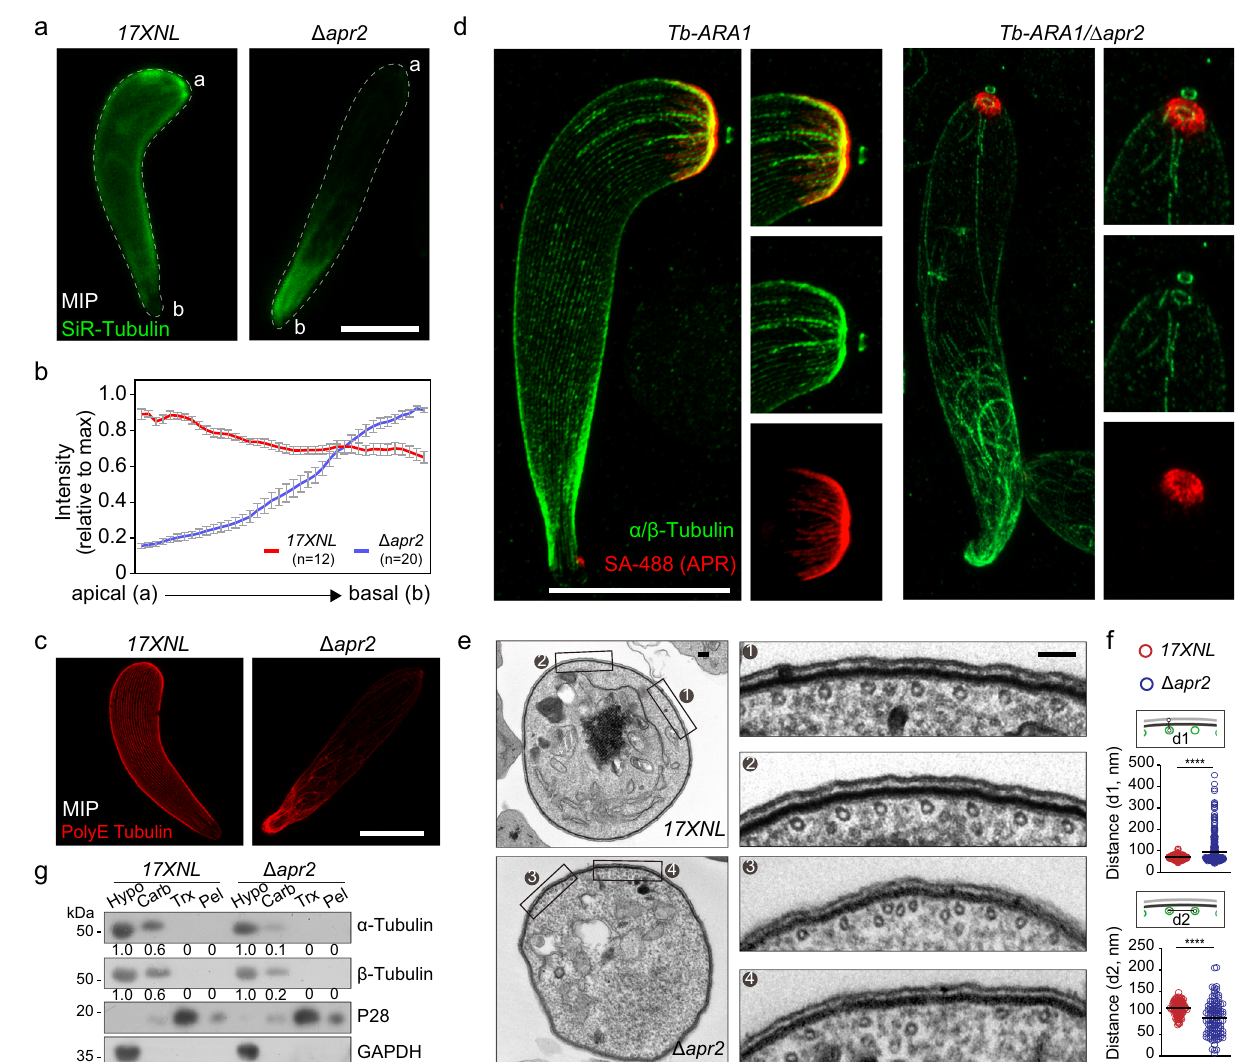
Fig. 7 | Cortical arrangement of SPMT is impaired in the APR2-null ookinetes. a Fullsection projections of fl uorescent signalinliving 17XNLand Δ apr2 ookinetes stained with SiR-Tubulin (MT fl uorescent probe). Representative maximum inten- sity projection (MIP) images were shown. a, apical end; b, basal end. Scale bars: 5 μ m. Three independently performed experiments with similar results. b Quanti fi cation of fl uorescent signal in a along pellicle from apical to basal. The maximum intensity was set as 1.0 and all signals were normalized. n is the number of ookinetes analyzed from two independent experiments. Data are shown means±SEM. c IFA of SPMTs by staining the glutamylated tubulin (PolyE) in the expanded 17XNL and Δ apr2 ookinetes. Representative maximum intensity projec- tion (MIP) image was shown. Scale bars: 5 μ m. Two independently experiments performed. d PL-U-ExM of the Tb-ARA1 and Tb-ARA1/ Δ apr2 ookinetes with APR stained with SA-488 (red) and SPMT stained with α - and β -Tubulin antibodies (green) respectively. Representative maximum intensity projection (MIP) images showing SPMT (green)and APR (red)inleftpanel,and enlargedviews of the apical inrightpanels.Scalebars:5 μ m.Threeindependentlyperformedexperimentswith similar results. e TEM of ookinete cross sections showing the arrangement of SPMTs underneath IMC in 17XNL and Δ apr2 parasites. Approximately 60 hollow (Fig. 9d). The mature-looking mutant ookinetes lost the crescent shape (Fig. 9e) and had an impaired gliding ability compared to the WT (Fig. 9f). As a consequence, both Δ aprp2 and Δ aprp4 mutants produced signi fi cantly decreased numbers of midgut oocyst in the infected mosquitoes (Fig. 9g). These defects caused by depletion of either APRp2 or APRp4 were in concordance with the phenotype of the Δ apr2 mutant.